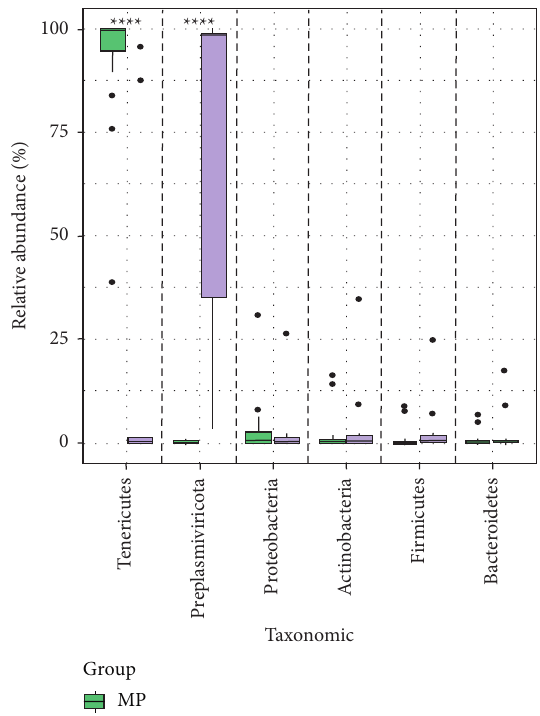
Figure 3: The most abundant phylum (mean relative abundances greater than 0.4% and penetrance greater than 40% among all samples) among the two groups. ∗ P < 0 . 05, ∗∗ P < 0 . 01, and ∗∗∗ P < 0 . 001. Kruskal–Wallis rank-sum test.